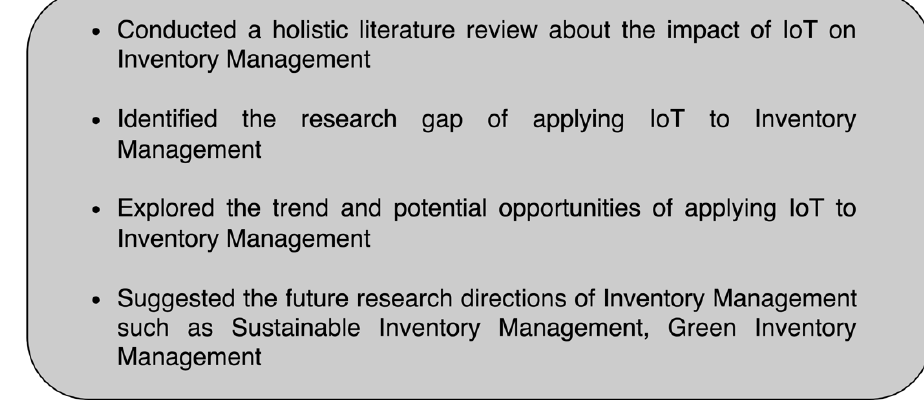
Figure 1. Main Contributions.